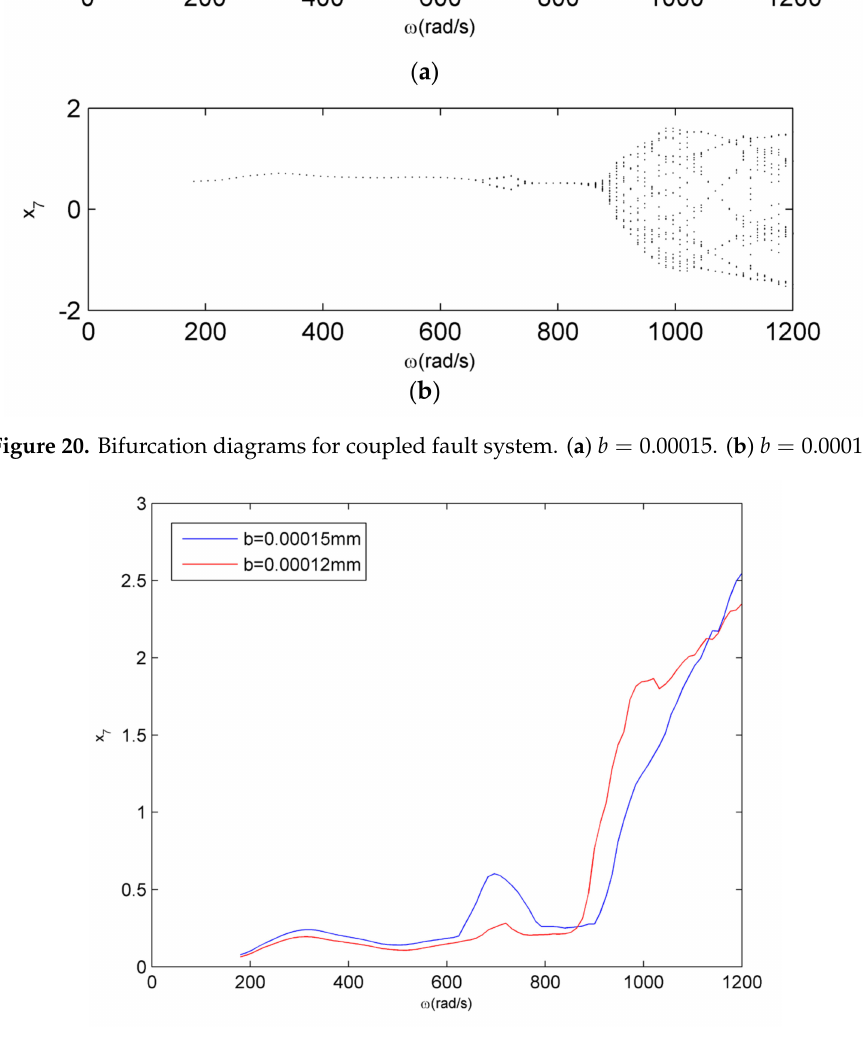
Figure 21. Comparison of the amplitude–frequency